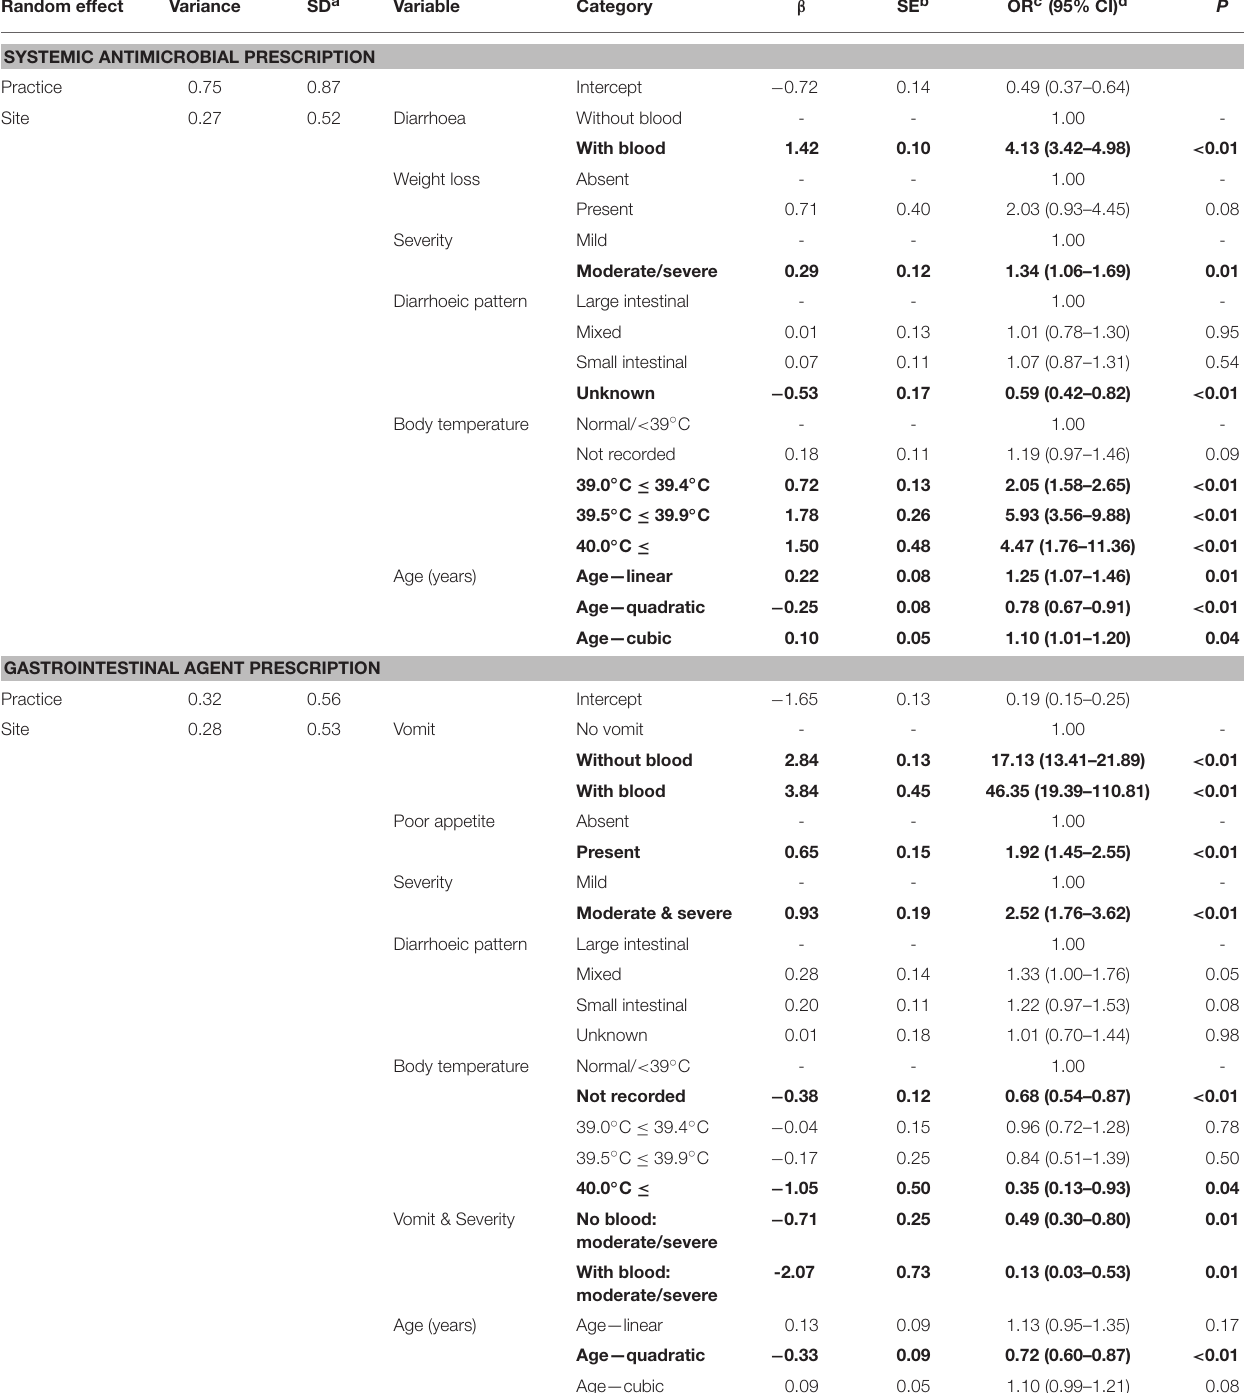
TABLE 5 | Parameter estimates from a finalised mixed effects logistic regression model, modelling on a case-level the presence of systemic antimicrobial and gastrointestinal agent prescription against a range of risk factors. Random